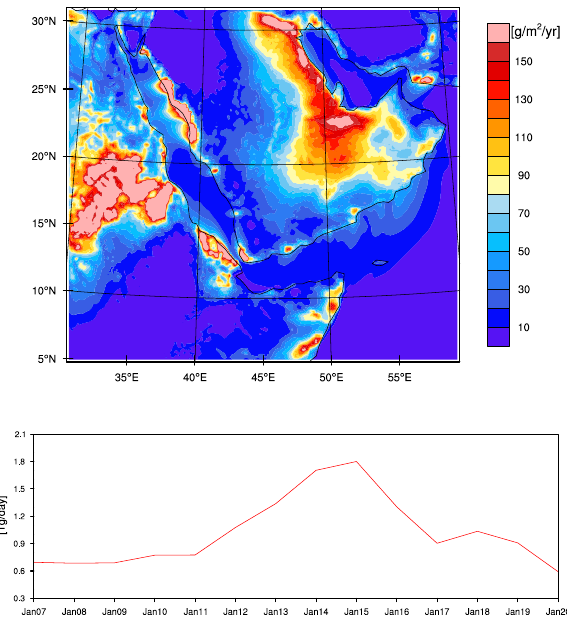
Fig. 11. The mean spatial distribution of the dust deposition rates [gm − 2 yr − 1 ] (upper panel) and a time series of the daily dust depo- sition [Tgday − 1 ] in the study region (lower panel) during the period of simulations of 7–20 January,